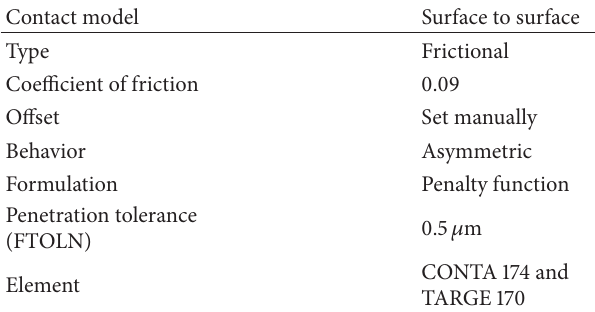
Table 3: Contact